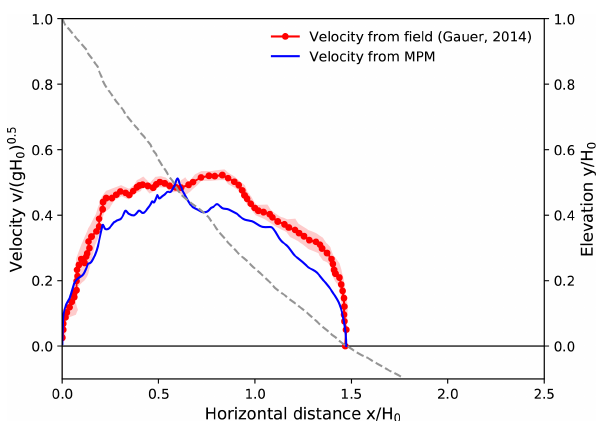
Figure 12. Front velocity distribution along the flow path for Case II: Weissfluh north ridge, 12 March 1982, a2 (Davos, Switzer- land). Drop height H 0 = 177m.